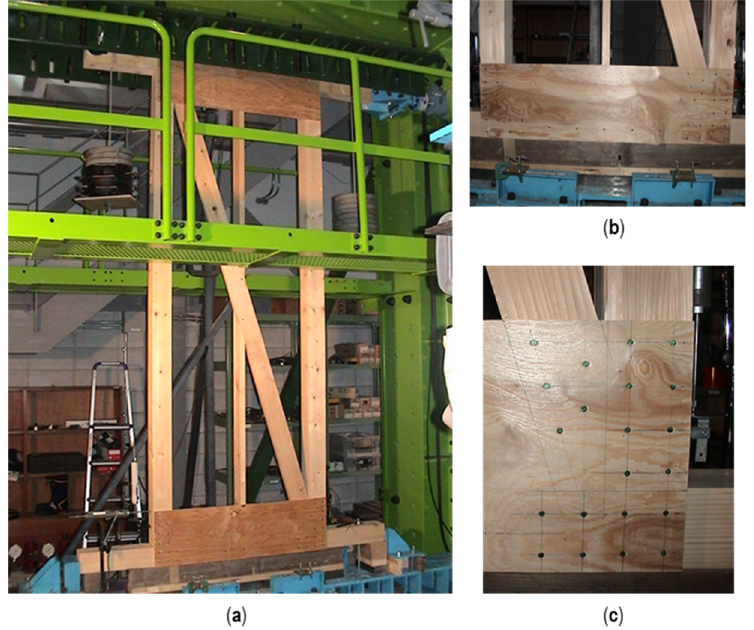
Figure 10. Test setup of the P and N full-scale in-plane cyclic test specimen: ( a ) overall view of the specimen; ( b ) P and N around the lower beam; ( c ) detail of the post-beam-brace connection.